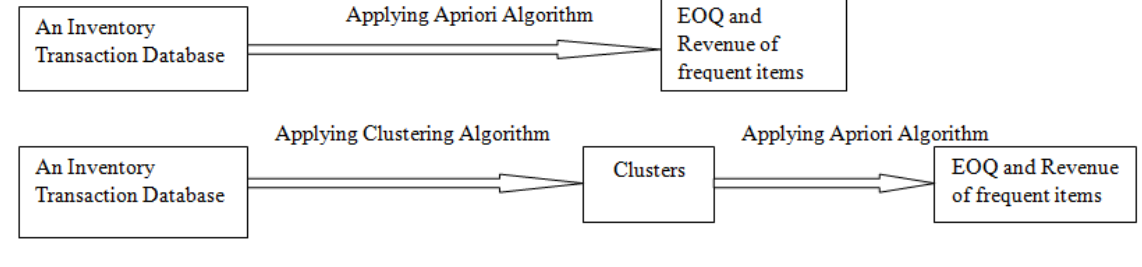
Fig. 3. Proposed research